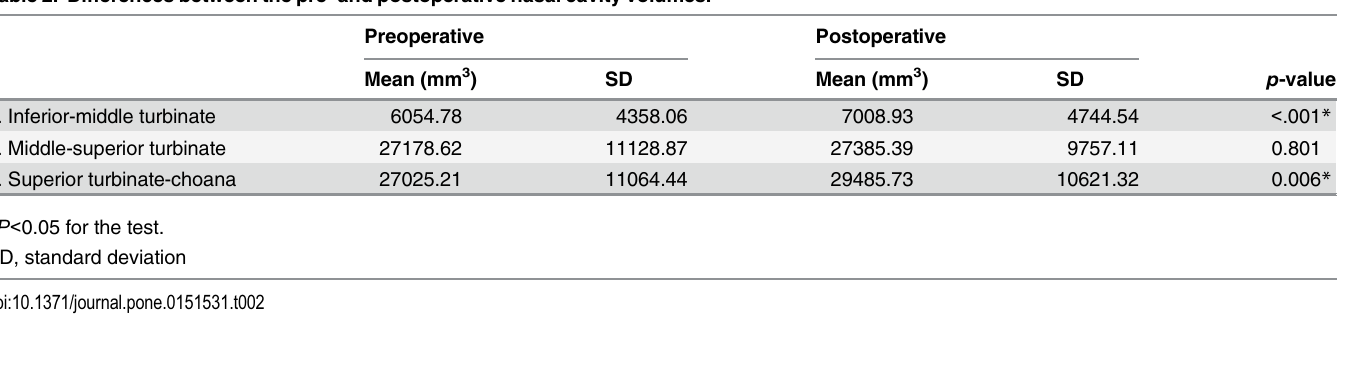
Table 2. Differences between the pre- and postoperative nasal cavity